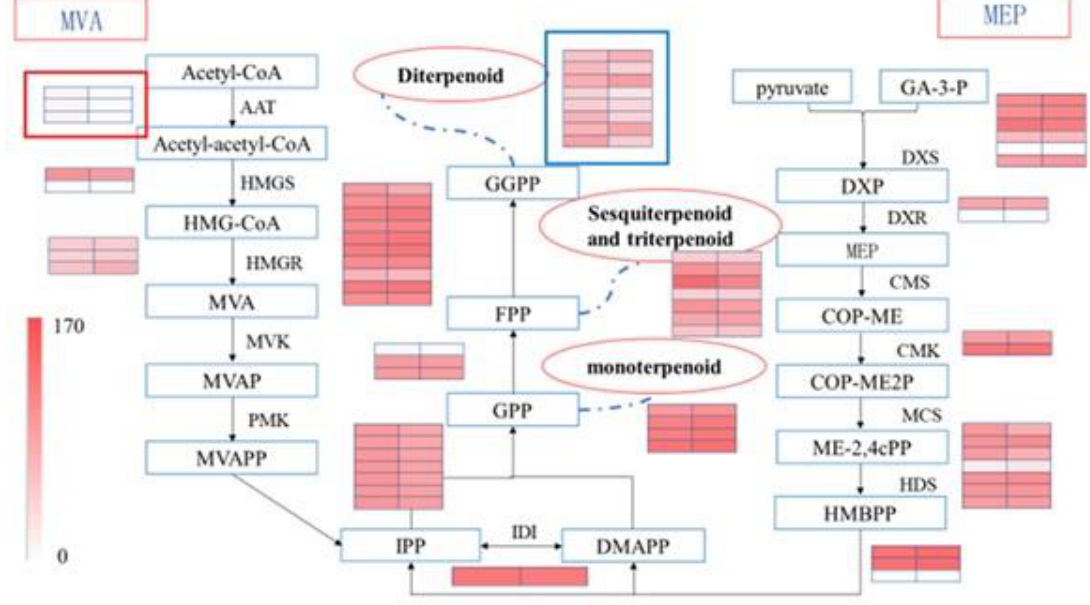
Figure 7. Expression of differentially expressed genes in the synthesis pathway of terpenoids in two chemical types of C.